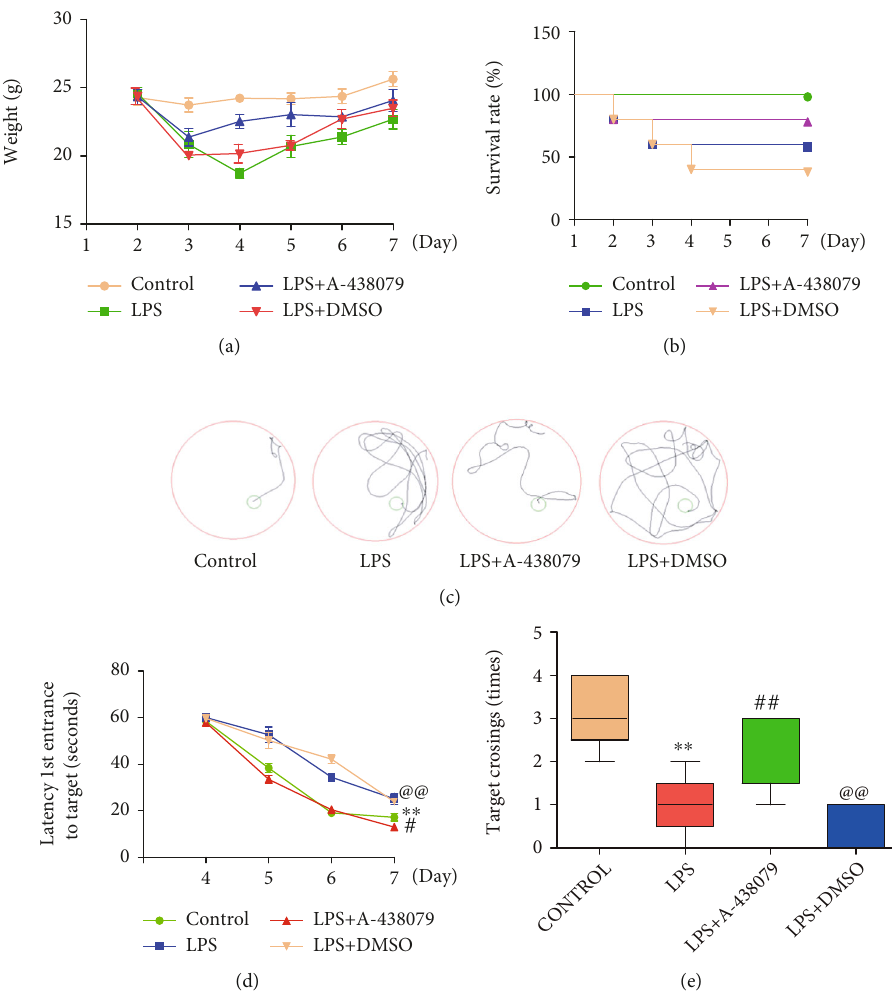
Figure 1: Treatment with P2X7R inhibitor A-438079 improved LPS-induced cognitive dysfunction and SAE in mice. (a) A-438079 treatment rescued LPS-induced weight loss. (b) Treatment of A-438079 signi fi cantly alleviated the reduced survival rate in mice caused by LPS. (c) The distance traveled by each group to reach the platform during the training period. Mice traveling distance was signi fi cantly reduced after treatment with A-438079 compared with the LPS and LPS+ DMSO groups. (d) Mice in LPS groups and LPS + DMSO groups expressed a signally longer escape latency than the control group. Treatment with A-438079 signi fi cantly reduced the extension of the escape latency after LPS treatment, n = 5 . All data are expressed as mean ± SD . ∗∗ P < 0 : 01 vs. control, # P < 0 : 05 vs. LPS group, and @@ P < 0 : 01 vs. LPS + A − 438079 group. (e) The number of times the mice crossed the platform was signi fi cantly reduced in the LPS group compared with the control group but increased after treatment with A-438079 compared with the LPS group, moreover, the number of mice crossing the platform in the LPS + DMSO group was signi fi cantly decreased compared with the LPS + A − 438079 group; n = 5 . All data are expressed as mean ± SD . ∗∗ P < 0 : 01 vs. control, ## P < 0 : 01 vs. LPS group, and @@ P < 0 : 01 vs. LPS + A − 438079